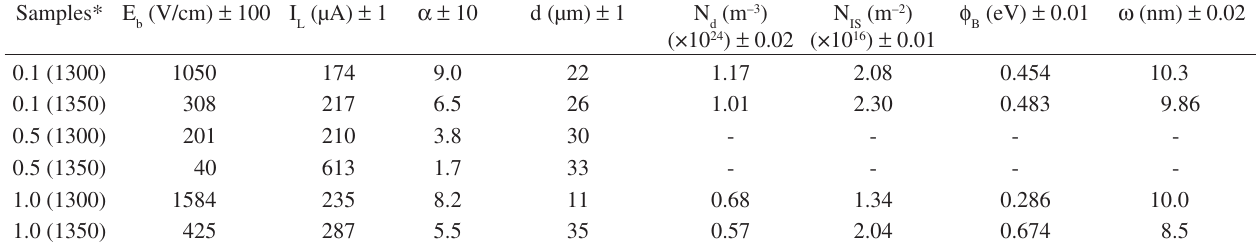
Figure 2. SEM micrographs of ZPC ceramics with different content of Pr The samples of micrographs showed in Figures a), b), c) have been sintered at 1300 °C and d), e), f) at 1350 °C. Table 1. The current-voltage ( I-V ) and capacitance-voltage ( C-V ) characteristic parameters of ZPC varistors with different content of Pr at 1300 and 1350 °C. The nonlinear coefficient ( α ) has been calculated for range values between 1-10 mA/cm 2 and leakage current (I the breakdown electrical